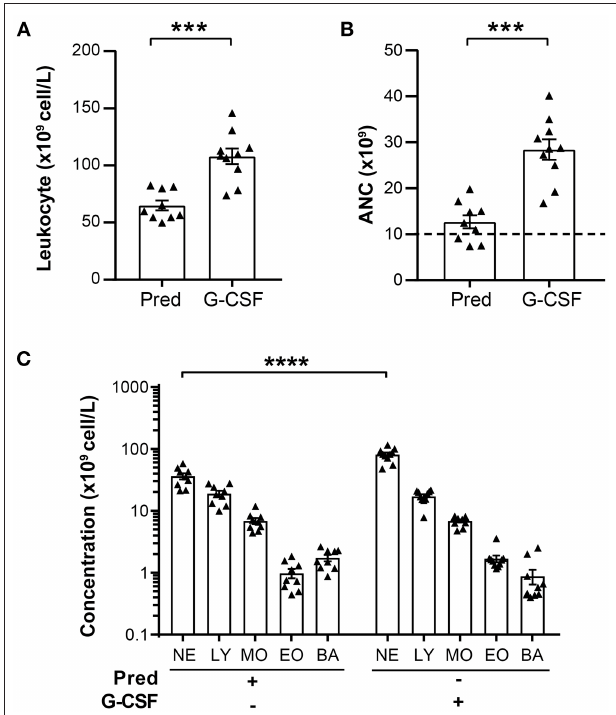
FIGURE 1 | Leukocyte composition in prednisone and G-CSF GCs. (A) Total leukocyte concentration in prednisone and G-CSF-derived GCs. (B) ANC calculated for a final GC volume of 350ml. The dashed line indicates the minimal number of neutrophils (10 10 ) required for granulocyte transfusion. (C) Concentration of leukocyte populations (neutrophils, NE; lymphocytes, LY; monocyte, MO; eosinophils, EO; basophils, BA) in prednisone and G-CSF GCs expressed as cell number per liter. Each dot represents an individual GC donor. Statistical analysis: Mann-Whitney test performed to compare leukocyte concentration and ANC between prednisone and G-CSF GCs: *** p -value < 0.001. Sidak multiple comparisons test performed to compare the concentration of leukocyte populations between prednisone and G-CSF GCs: **** p -value < 0.0001. These data are compiled from the analysis of 9 prednisone and 10 G-CSF